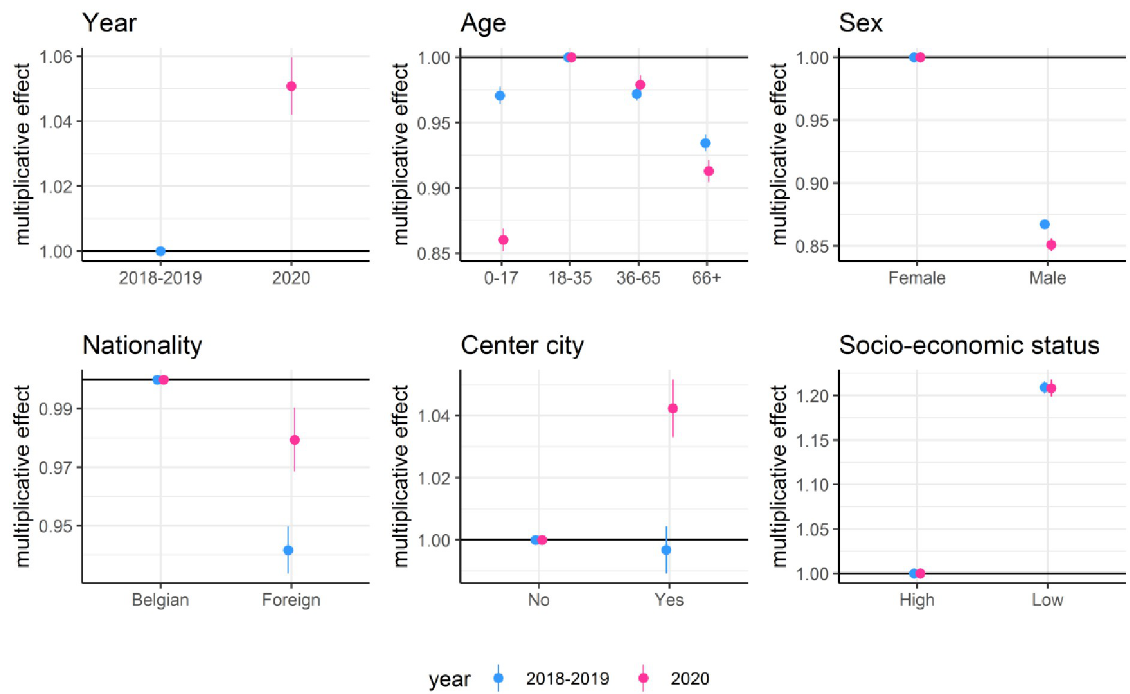
Fig 4. Multiplicative effect and associated 95% confidence intervals of covariates on the expected number of acute diagnoses per patient per year. Separate parameters were estimated for the period February 1, 2018 to January 31, 2020 and the period February 1, 2020 to January 31, 2021 which are labeled 2018–2019 and 2020,